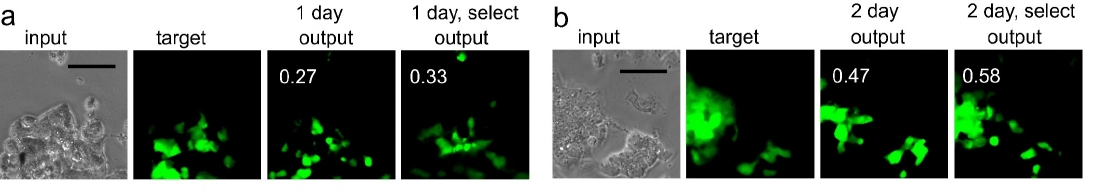
Figure 2. CSC image mapping from bright-field cell images. ( a ) Output examples by AI models trained with datasets of 1-day and 1-day-selected for an input phase-contrast image. Numbers in output images were F-measure values between output and target images of GFP fluorescence. Bar = 100 μ m. ( b ) Output examples for datasets of 2-day and 2-day-selected. Bar = 100 μ m. ( c – e ) Com- parison of AI models trained with various datasets. Bright-field cell images chosen for AI to make outputs were taken from the same dataset category used for training the AI model. The values for recall ( c ), precision ( d ), and F-measure ( e ) were calculated. Closed circles indicate maximum values. Mean ± S.E.M., n = 1000. ** p < 0.01. 3.2. Versatility of Application of AI to Datasets Other Than the Training Dataset To examine the versatility of AI, we evaluated AI models using different kinds of test datasets that were not used to train the AI. Examples are shown in Figure 3a. The AI model of 1-day culture showed a mean F-measure value of 0.26 for the test dataset of the 1-day culture used as control (Figure 3b). Feasibly, we observed an approximately equal value for the test dataset of the 1-day-selected culture because the test dataset was essentially the same as the training dataset for the AI model. Interestingly, the value significantly decreased for both test datasets for the 2-day culture. The AI model of the 1-day-selected culture similarly showed a significantly low F-measure value of 0.26, while the control showed a value of 0.29 (Figure 3c). AI models trained with 1-day culture datasets might be incapable of depicting CSC images from the phase-contrast image of 2-day culture. In contrast, AI models of 2-day and 2-day-selected cultures showed similar F-measure values as the test datasets of 1-day and 1-day-selected cultures (Figure 3d,e).